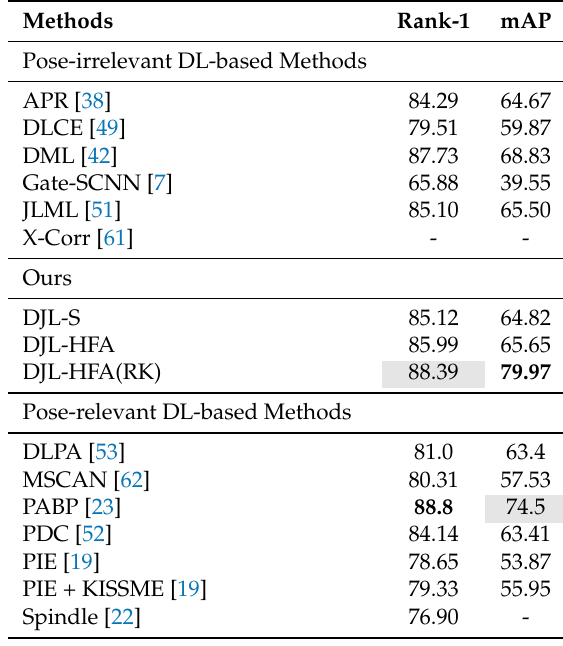
Table 4. Comparison with state-of-the-arts on Market-1501. Rank-1 accuracy (%) and mAP (%) are shown. The best result is marked in bold while the second best in gray.